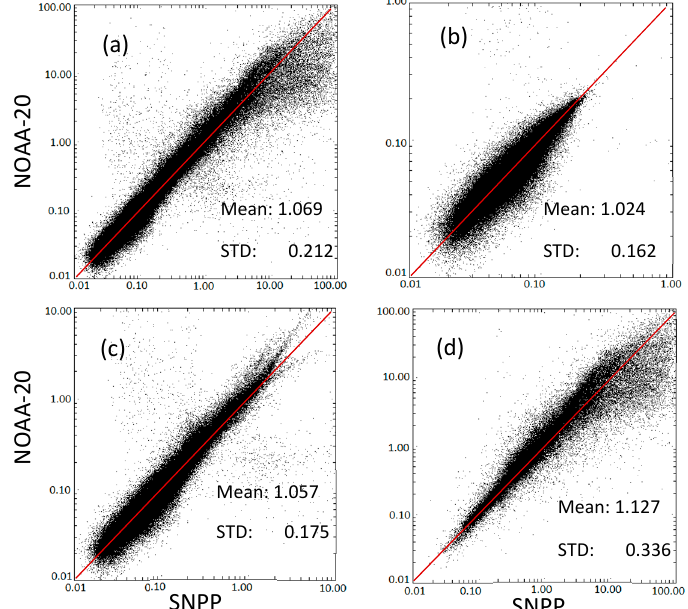
Figure 2. Scatter plots of VIIRS NOAA-20 versus SNPP Chl-a in ( a ) global all regions, ( b ) global oligotrophic waters, ( c ) global deep waters, and ( d ) global coastal and inland waters on 21 June 2018.